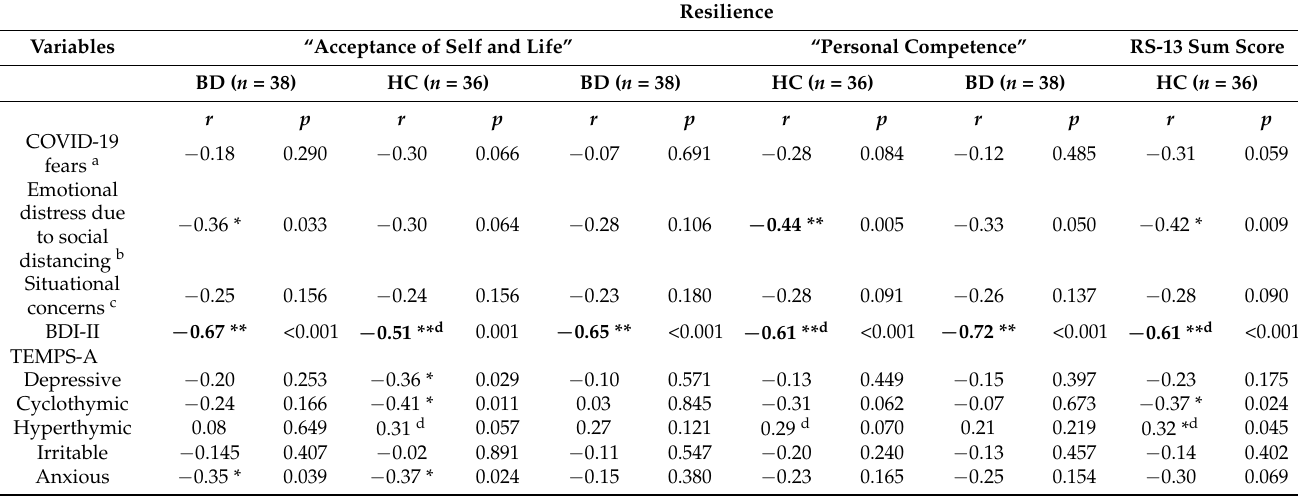
Table 2. Correlations between the RS-13 sum score, “acceptance of self and life”, and “personal competence” and COVID-19 fears, emotional distress, situational concerns, BDI-II, and TEMPS-A. Resilience “Acceptance of Self and Life” “Personal